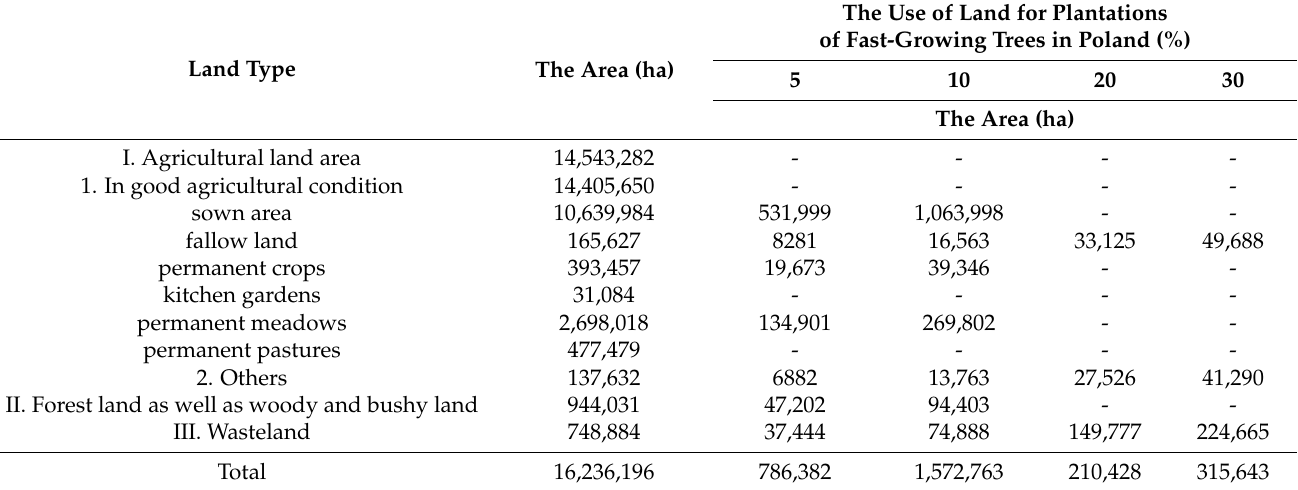
The Use of Land for